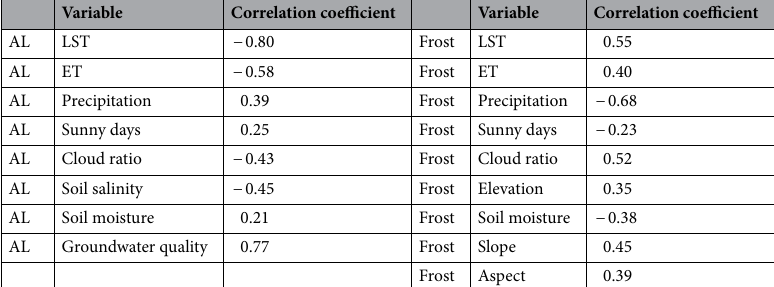
Table 12. Correlation coefficient analysis between AL, frost-affected areas and predisposing variables.